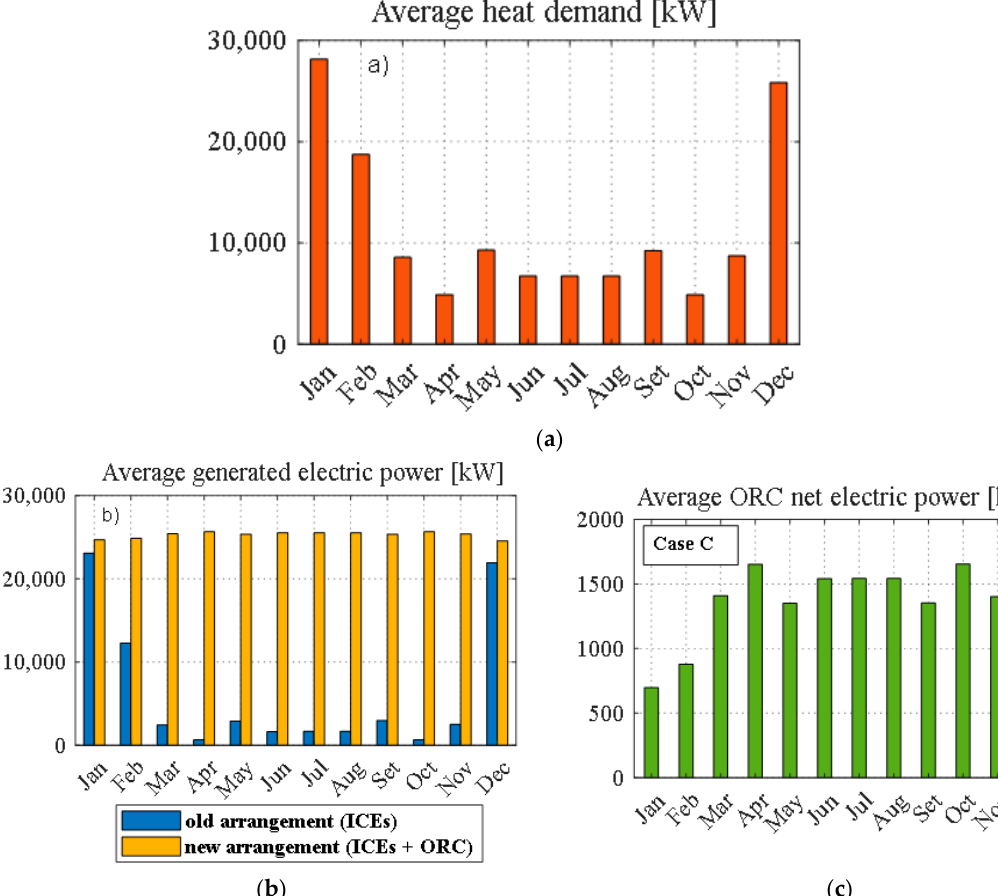
Figure A1. Monthly profile of: ( a ) Thermal power demand; ( b ) Electric power generated by the old arrangement and the new one; ( c ) ORC net electric power output.